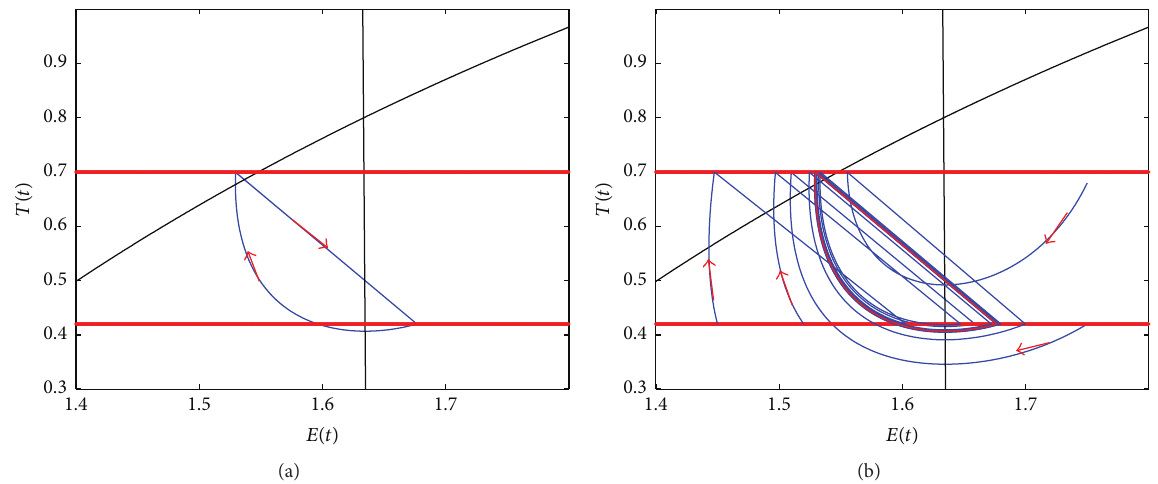
Figure 2: The existence and stability of order-1 periodic solution for model (4) with 𝑝 = 0.1 , 𝑞 = 0.4 , and 𝜏 = 0.2 : (a) the existence; (b) the orbital asymptotical stability.